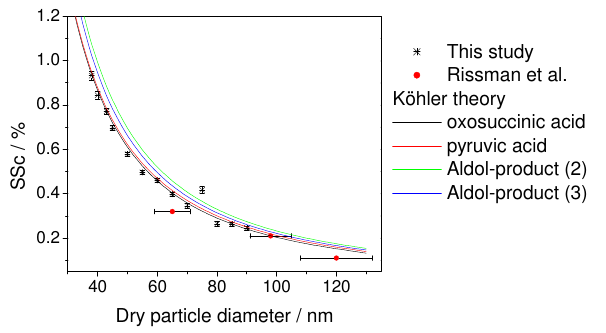
Fig. 16. The critical supersaturation of oxosuccinic acid as a function of dry particle diameter. Experimental data are com- pared to K¨ohler theory (dissociation based on the first acid constant, surface tension of water). Four K¨ohler curves are shown, using the following data: black: pure oxosuccinic acid. Red: pyruvic acid, M =88.06g/mol; ρ =1.250g/ml; pKa=2.49. Green: citroylformic acid; M =220.13g/mol; ρ =1.795g/ml, pKa=1. Blue: 4-hydroxy-4-mehtyl-2-ketoglutaric acid; M =176.12g/mol, ρ =1.579g/ml, pKa=1.